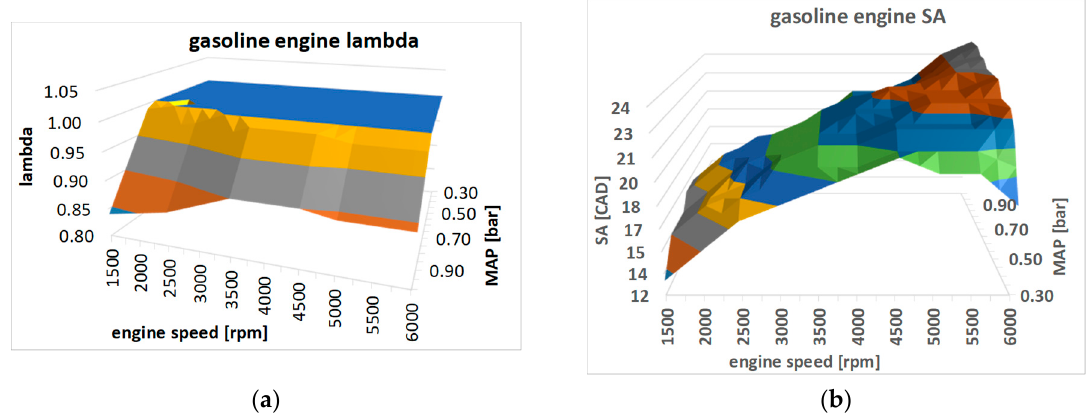
Figure 1. λ ( a ) and SA ( b ) maps of the gasoline ‐ fueled engine vs. engine speed [rpm] and MAP [bar]. For both hydrogen configurations, the A/F ratio is fixed at λ = 2 for all the operating conditions, while the SA is set to the maximum brake torque value. Figure 2a,b shows the SA maps adopted for the TC and SC engine, respectively.